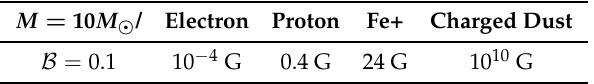
= 0.1 is given for B 10 M ∼ (cid:12)